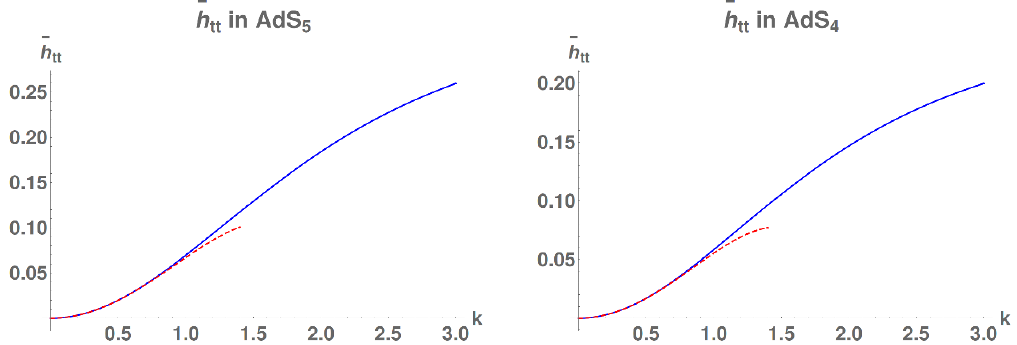
Figure 4 . Values of (cid:22) h tt ( k ) in the analytic gauge, for AdS 5 and AdS 4 . Solid blue: numerical results. Dashed red: perturbative expansions in powers of k , eqs. (B.8),